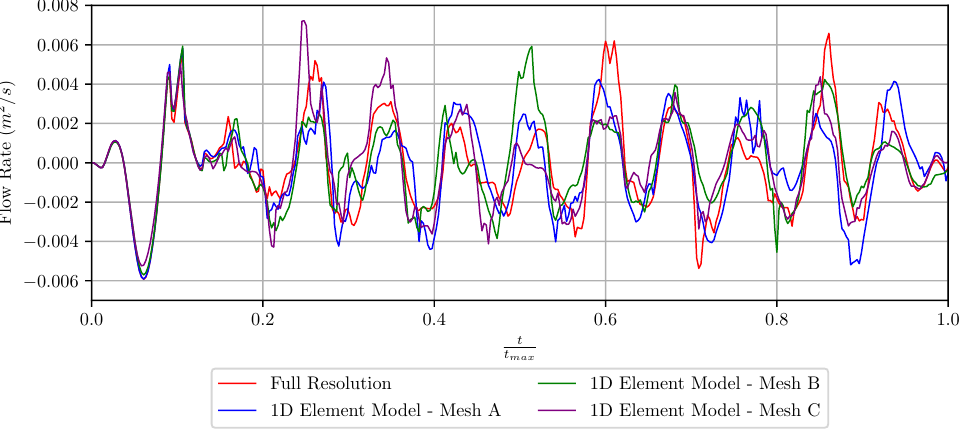
Figure 15. Flow rate through bottom orifice in violent slosh test case using one-dimensional orifice element